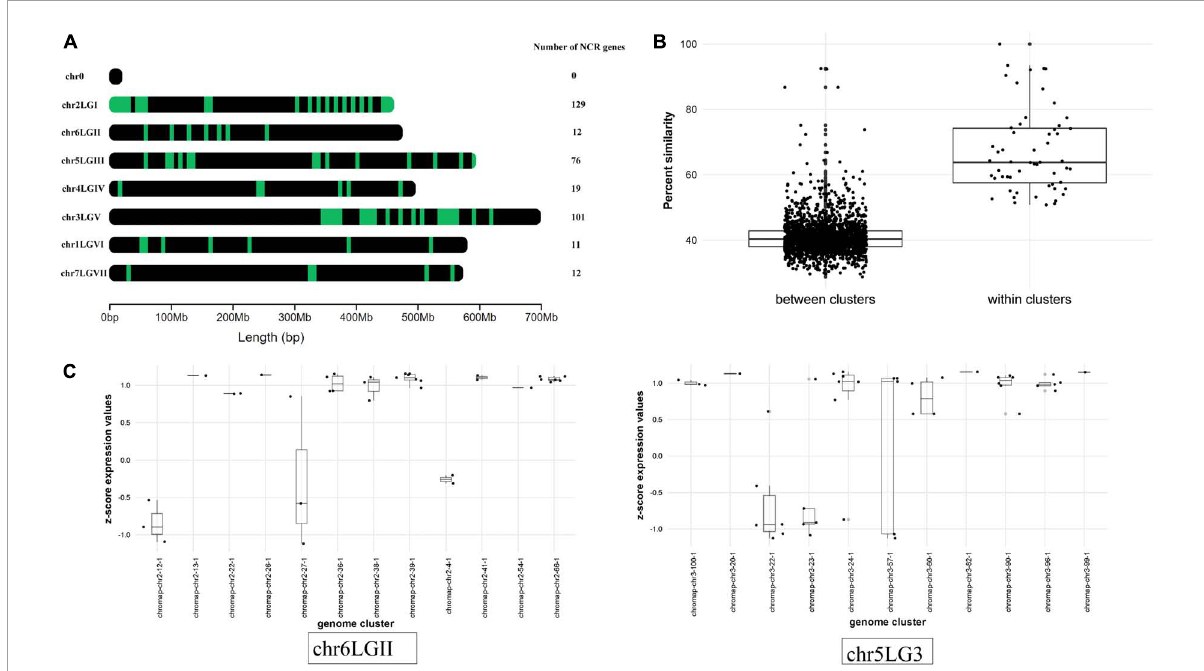
FIGURE4 (A) Localization of NCR genes in P. sativum genome. Green dashes indicate NCR genes. (B) Comparison of the average percentage similarity of NCR genes within and between clusters in the genome using boxplots. Each comparison group contains the results of a pairwise alignment of NCR peptides with each other in the form of % similarity of their sequences. The group “within clusters” contains the results of the alignment of peptides among themselves within the same cluster in the genome. The “between clusters” group contains the results of the alignment of peptides belonging to different clusters with each other. (C) Evaluation of the NCR gene expression at 12 dpi within and between clusters in the genome. The level of NCR gene expression in clusters is represented by the transformation of log2(CPM) into a z -score. Chromosomes with a more pronounced effect are selected for